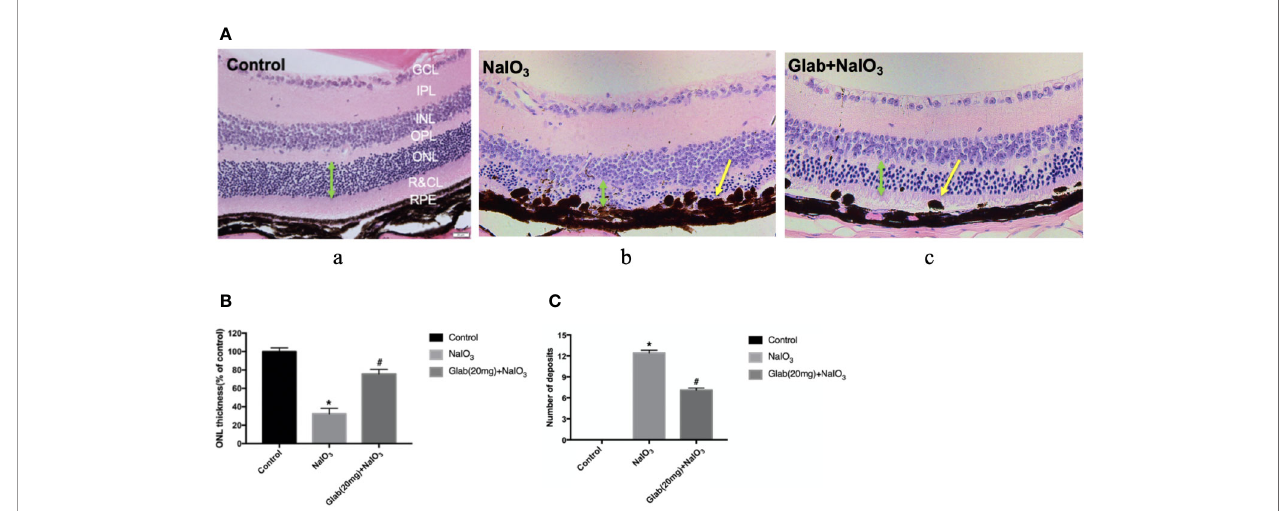
FIGURE 6 | Effects of Glabridin on the retinal layers and number of deposits on the retinal pigment epithelial (RPE) layer as seen in H&E staining in vivo . (A) Haematoxylin and eosin (H&E) staining of the retina on day 28 after NaIO 3 and Glab treatment. a, retina of normal mice (Control); b, retina treated with NaIO 3 (25mg/kg) (NaIO 3 ); c, retina treated with Glabridin (20mg/kg) plus NaIO 3 (Glab(20mg)+NaIO 3 ). The arrangement of cells in the outer nuclear layer (ONL), rods and cones layer (R&CL), and retinal pigment epithelium(RPE) layer were signi fi cantly disordered in the NaIO 3 group, compared with the control group, while Glab signi fi cantly attenuated the disorder of those layers induced by NaIO 3 in Glab+NaIO 3 group, compared with NaIO 3 group. (B) The thickness of ONL, the most severely damaged layer, was compared among groups and the results showed that NaIO 3 signi fi cantly reduced the thickness of ONL, compared with the control group (* P < 0.05), while Glab signi fi cantly protected the layers and increased the thickness of ONL, compared with NaIO 3 group ( # P < 0.05). (C) Both NaIO 3 and Glab+NaIO 3 groups signi fi cantly increased the number of deposits on the RPE layer, compared with the control group (* P < 0.05), however, Glab signi fi cantly decreased the number of deposits on the RPE layer in the Glab+NaIO 3 group, compared with NaIO 3 group ( # P <